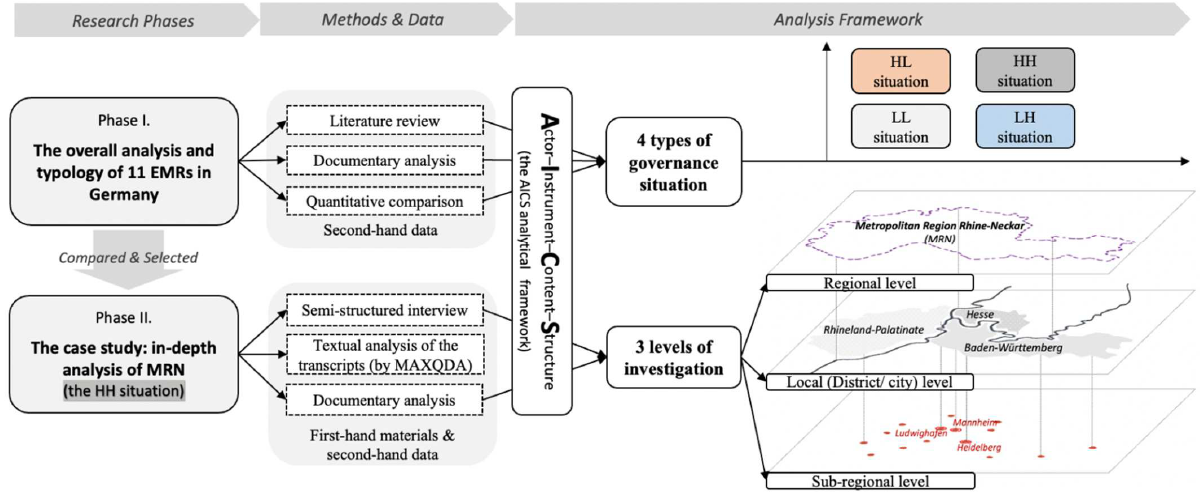
Figure 6. A flow chart of main phases of the research design–method, data and analysis framework). Source: the